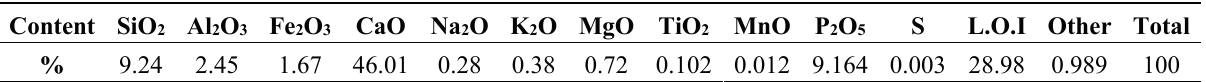
Table 2. Major element geochemical analysis of a representative phosphate ore sample from the Lar Mountains. L.O.I: Loss on